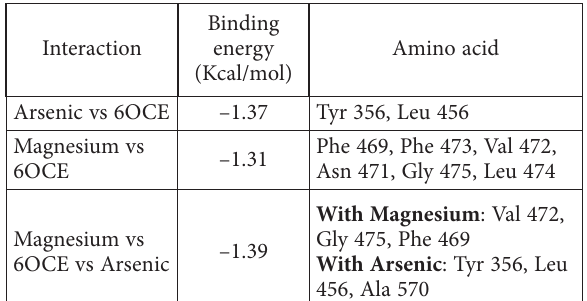
Table 2. Molecular interaction between transport protein with As 3+ and Mg 2+ ions